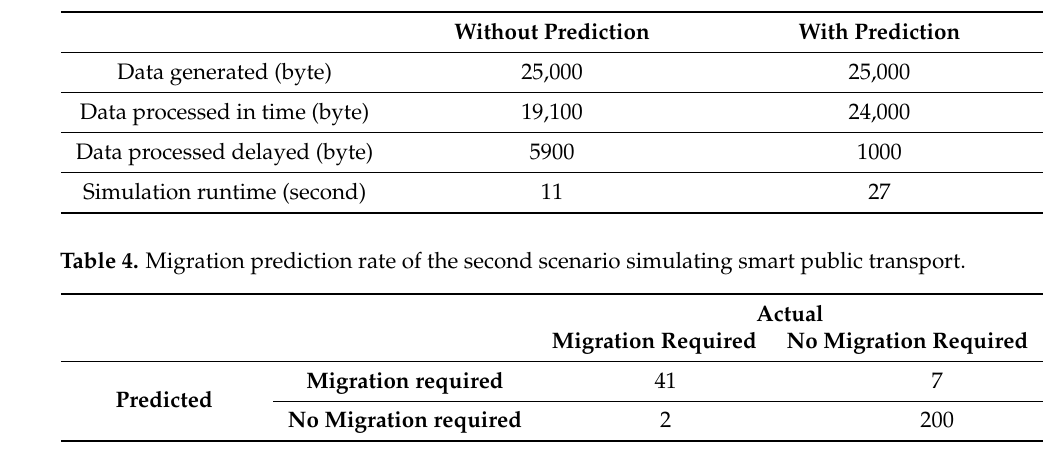
Table 3. Results of the second scenario simulating smart public transport.